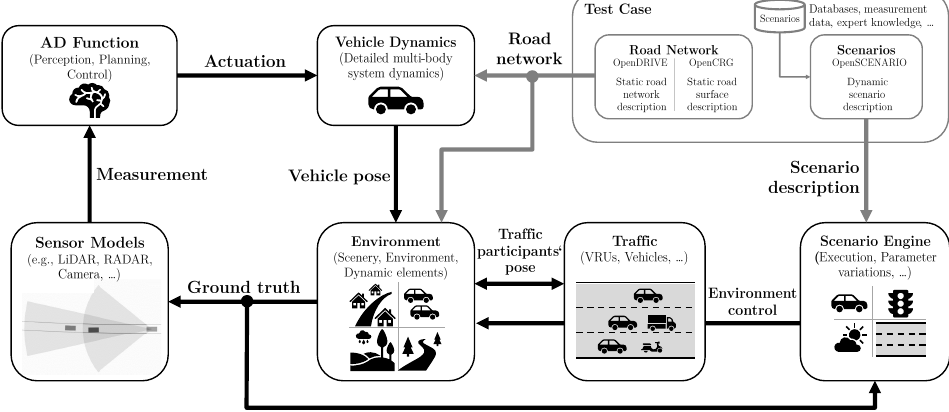
Figure 5. Overview of the necessary subsystems for a virtual validation framework for